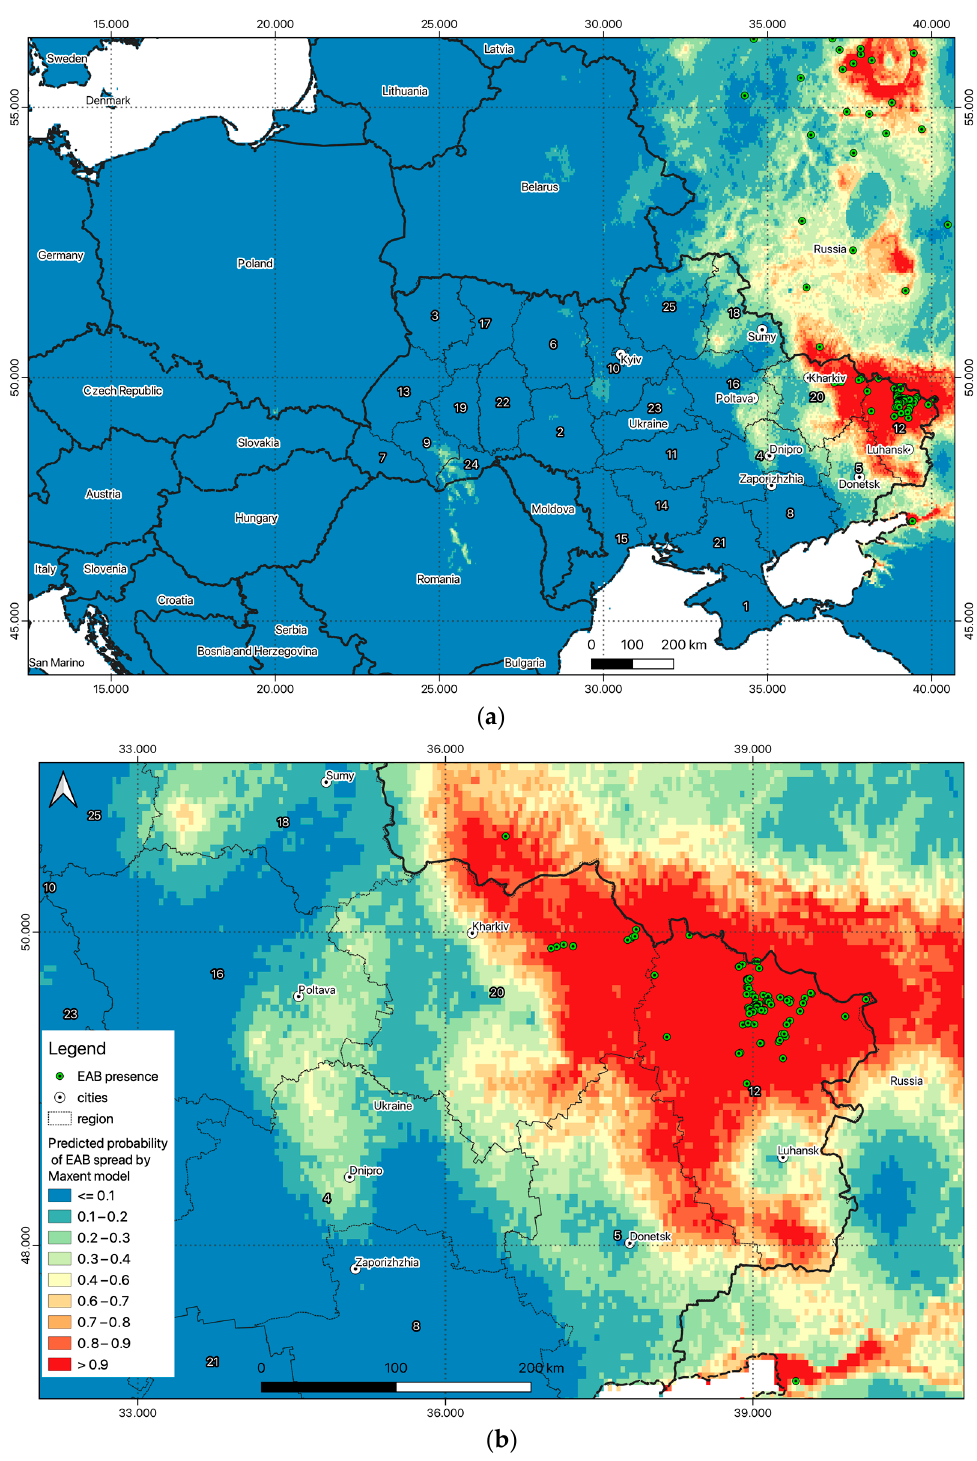
Figure 2. Predicted distribution area for EAB estimated by maximum entropy modeling. ( a ) whole analyzed territory; ( b ) a fragment of the territory with the highest probability of EAB spread. Green circles are points where EAB was detected. Numbers indicate cities and regions of Ukraine: 1— Autonomous Republic of Crimea; 2—Vinnytsia; 3—Volyn; 4—Dnipropetrovsk; 5—Donetsk; 6— 20—Kharkiv; 21—Kherson; 22—Cherkassy; 23—Chernivtsi; 25—Chernihiv. The color reflects the predicted probability of EAB spread at each grid cell (see the scale in ( b )).